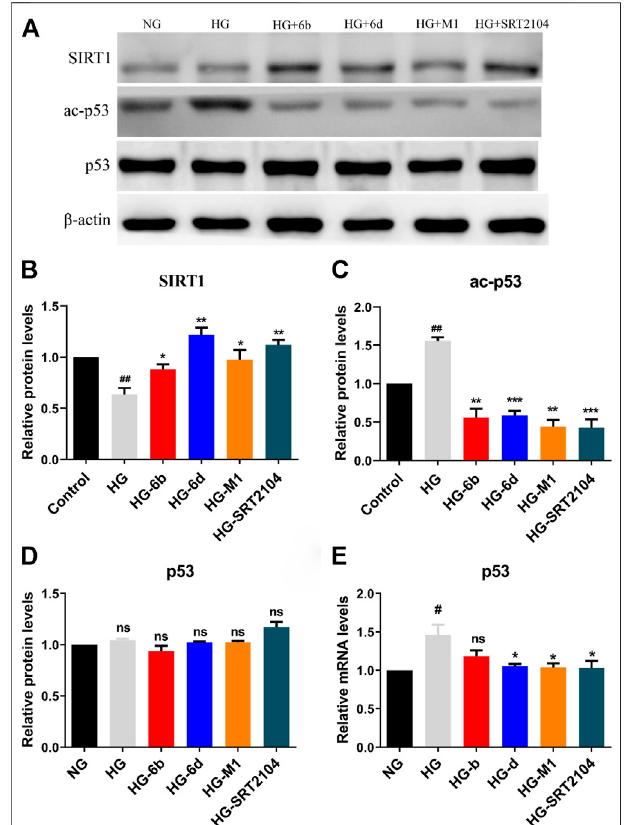
FIGURE 7 | (A – D) Western blot analysis protein expression levels of SIRT1, ac-p53, and p53 in HG stimulating HK-2 cells treated with the